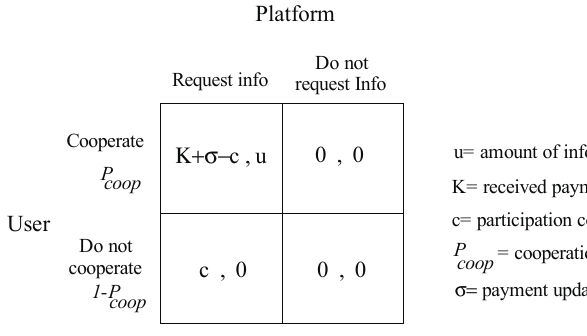
Figure 7. Final representation of our model as normal form game.